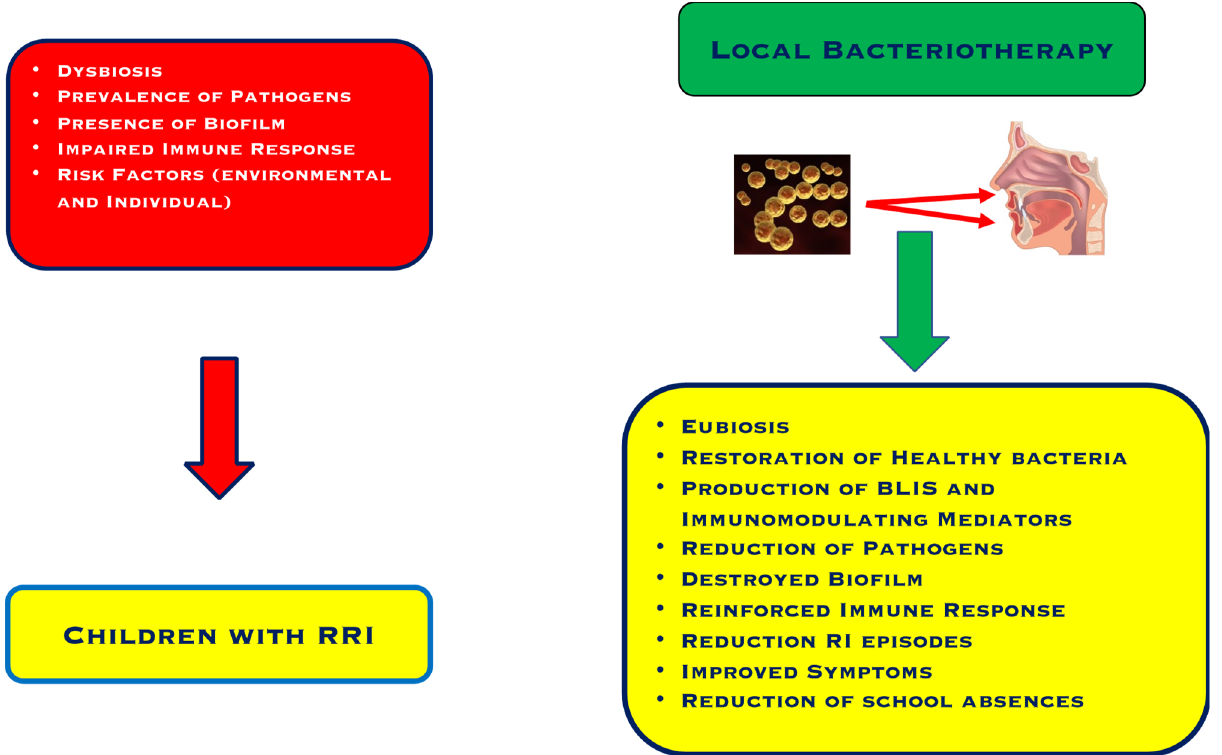
Figure 1. Characteristics of children with recurrent respiratory infections and the effects of Local Bacteriotherapy.